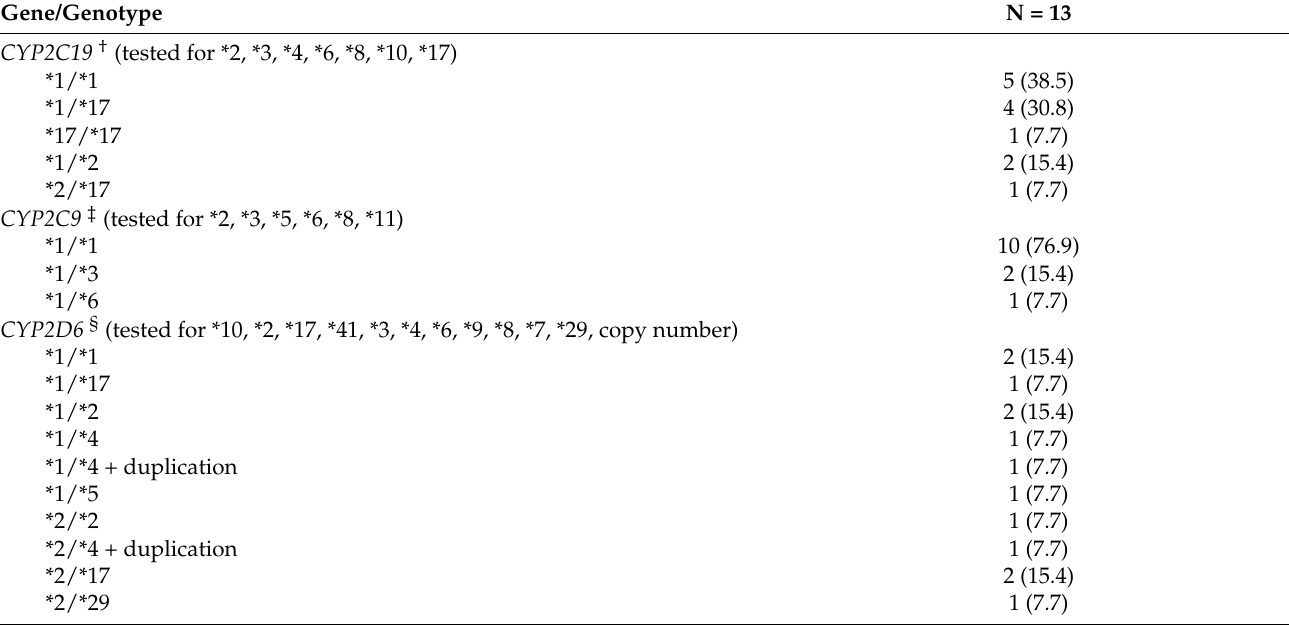
Table 2. Genes/Variants Tested with the PGx Panel and Patients’